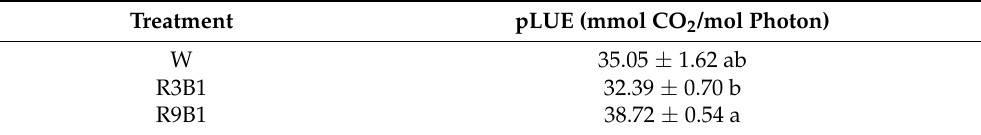
Figure 4. Effects of light quality on daily average of intercepted PPFD and proportion of the canopy in ‘Micro-Tom’ in Experiment 2. The intercepted PPFD of the canopy was calculated as the difference between the average PPFD on the top and bottom of the canopy. The intercepted PPFD proportion was calculated as the ratio of the intercepted PPFD to the average PPFD above the top of the canopy. The PPFD of the three treatments was set at 300 µ mol m − 2 s − 1 . W: white light; R3B1: red/blue ratio = 3; R9B1: red/blue ratio = 9. Table 8. Effect of light quality on the pLUE of leaves in ‘Micro-Tom’ 10 DAT in Experiment 2. pLUE is the ratio of net photosynthetic rate to PPFD and expressed in mmol CO 2 /mol photon. Each value represents the mean ± standard error. Different letters indicate significant differences among the treatments based on Tukey − Kramer’s test at the p < 0.05 ( n = 4). W: white light; R3B1: red/blue ratio = 3; R9B1: red/blue ratio = 9.